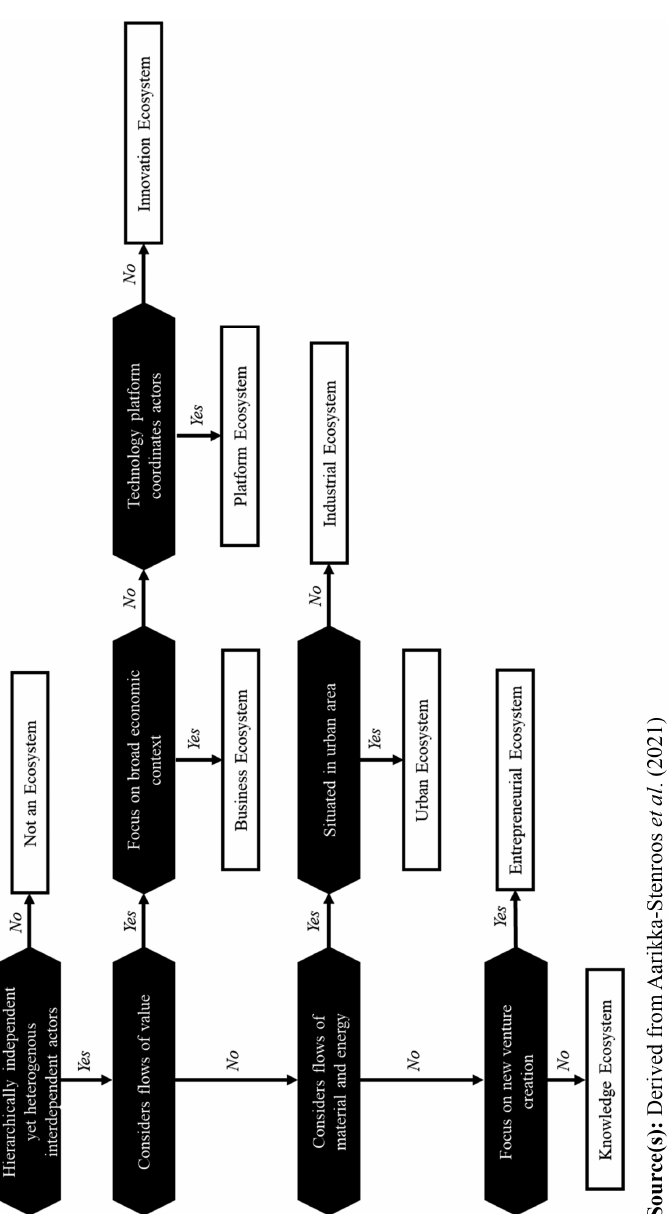
Figure 1. A heuristic